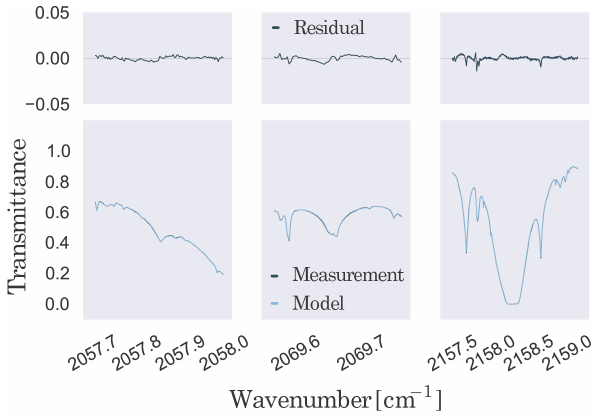
Figure 2. Spectral fits and residuals for CO for one particular Karl- sruhe spectrum recorded in the MIR for the three narrow band spec- tral